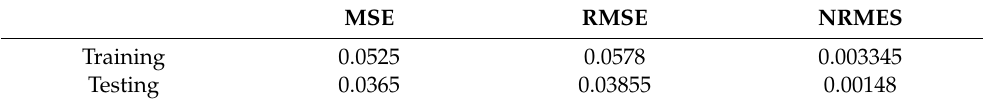
Table 7. Results of the LSTM model’s performance in predicting the prices of the EOS